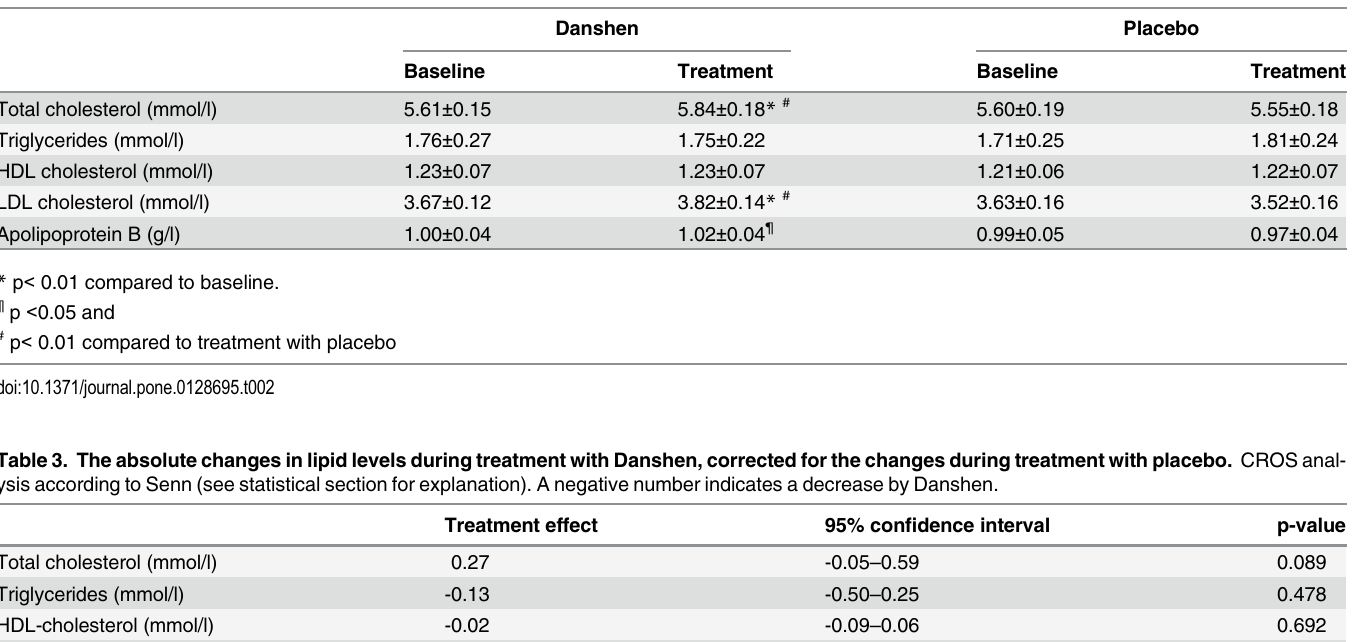
Twenty minute automatic blood pressure measurements were performed prior to placebo and Danshen administration ( ‘ baselines ’ ). Again, both systolic and diastolic blood pressures were not different at baseline (systolic blood pressures before Danshen 140±3 mmHg and before placebo 140±3 mmHg. Corresponding values for diastolic blood pressure were 85±2 mmHg and 85±2 mmHg, respectively).